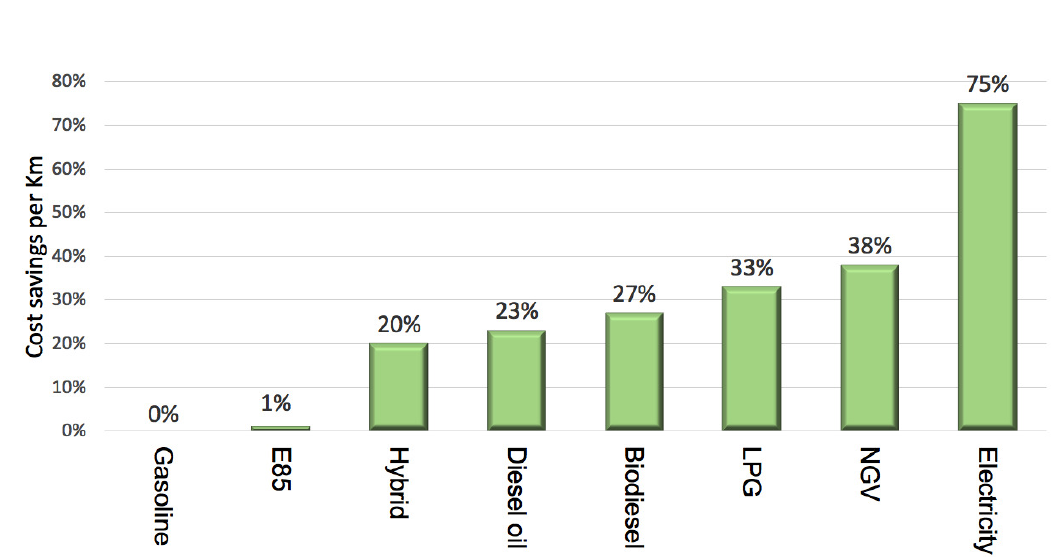
Figure 1. Comparison of savings in cost per kilometer offered by vehicles powered by Gasoline, Ethanol (E85), Hybrid, Diesel oil, Biodiesel, Liquefied Petroleum Gas (LPG), Natural Gas Vehicle (NGV), and Electricity